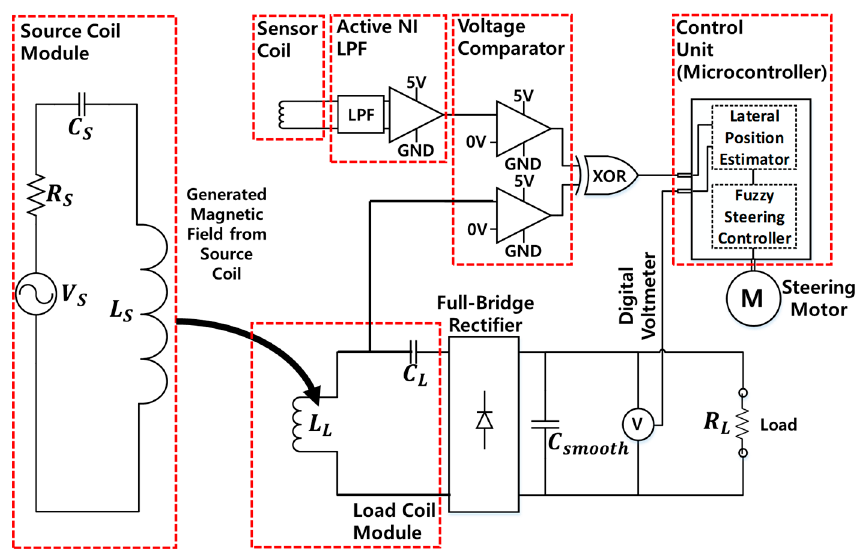
Figure 19. Overall circuit schematic for the experiment. Table 4. Measured value of each components for the circuit schematic shown in Figure 19.